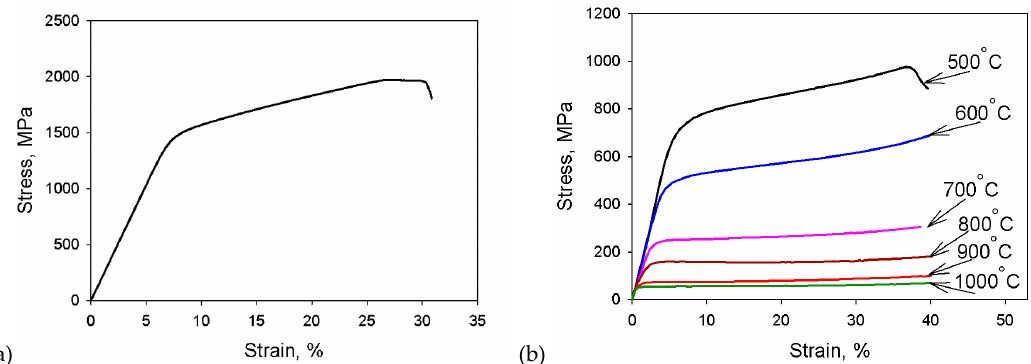
Figure 3. Flow curves obtained during compression at ( a ) 20 ° C or at ( b ) 500–1000 ° C of the Ti-15Mo/TiB TMC at a nominal strain rate 10 − 3 s − 1 .